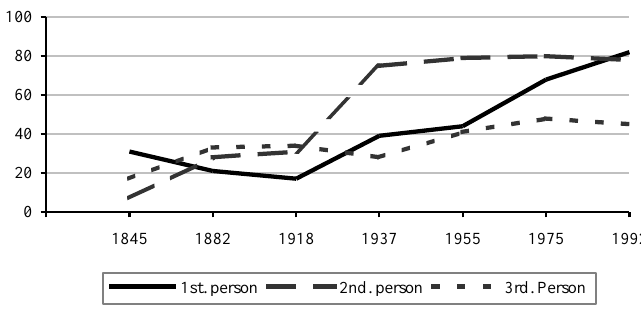
Figure 2. OVERT SUBJECTS ACCORDING TO GRAMMATICAL